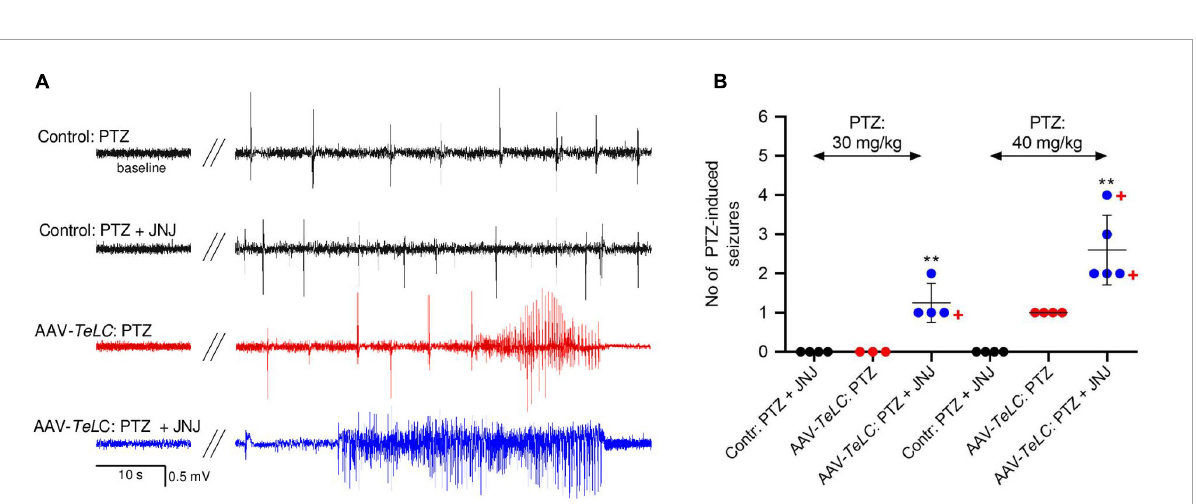
FIGURE7 The Y2 receptor antagonist JNJ 5207787 potentiates PTZ-induced seizures in AAV- TeLC -injected epileptic mice. (A) EEG traces after injection of 40 mg/kg PTZ i.p. or injection of the Y2 receptor antagonist JNJ 5207787 (20 mg/kg, i.p.) followed by PTZ (40 mg/kg, i.p.). Note that neither the low dose of PTZ nor PTZ + JNJ 5207787 induced seizures in naïve controls (black traces) nor in AAV- GFP -injected mice (not shown). PTZ induced significant convulsions in AAV- TeLC -injected mice (red trace) that were markedly augmented by prior 20 mg/kg JNJ 5207787 injection (blue trace). (B) Numbers of PTZ-induced seizures with and without JNJ 5207787 injection. Neither naïve controls (black circles) nor AAV- GFP -injected mice (not shown; together n = 8) presented epileptic spells after 30 or after 40 mg/kg PTZ without JNJ 5207787 ( n = 3 and 4, respectively; black filled circles). Mice previously injected with AAV- TeLC responded with no seizure (0/3) after 30 mg/kg PTZ; after 40 mg/kg PTZ all four mice responded modestly with 1 seizure (red filled circles). At both doses of PTZ, the number of seizures markedly increased when injected together with JNJ 5207787 (blue filled circles). Neither control mice ( n = 4) nor AAV- GFP -injected mice ( n = 3) showed changes in the EEG after JNJ 5207787 injection (not shown). +, indicate mice that died in seizures. Statistics (Student’s t -test): ** p < 0.01, respective AAV- TeLC and PTZ-injected with vs. without prior injection of JNJ 5207787. The important message of this experiment is that the Y2 antagonist is inactive in naïve mice and in mice without acute seizures. However, in mice with seizures, it augments the epileptic activity presumably by inhibiting the protective action of NPY (released primarily during seizures) on Y2